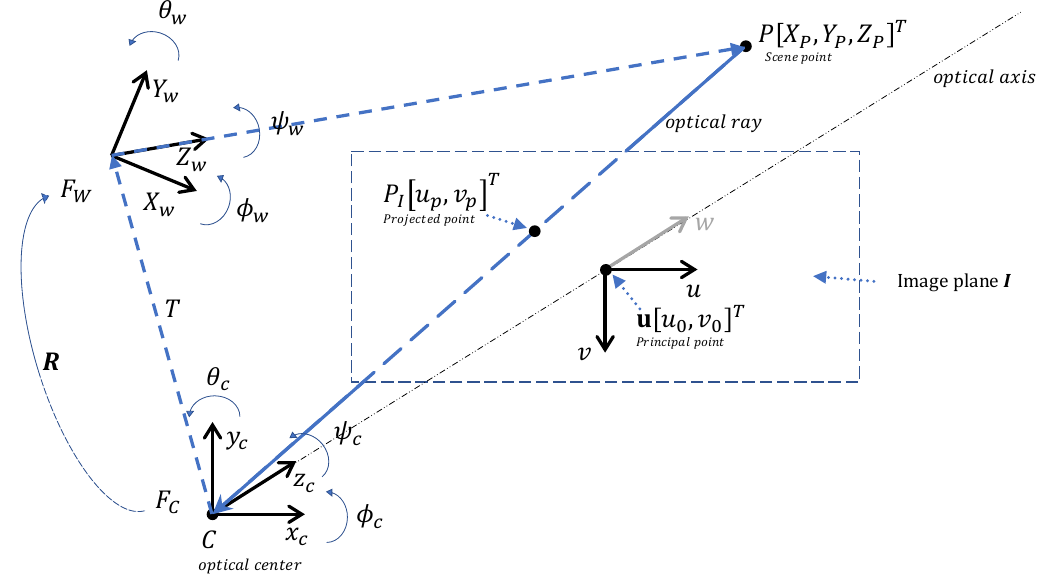
Figure 3. Perspective